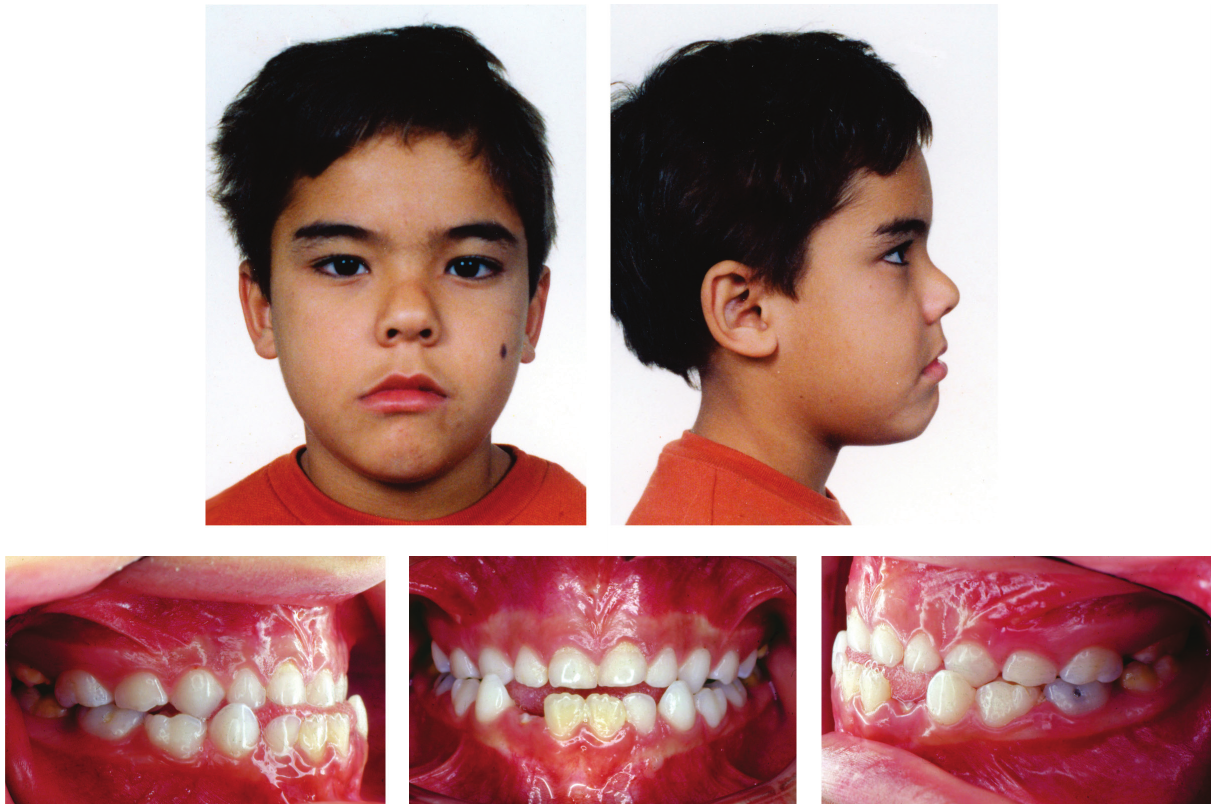
Figure 1- Extra-oral and Intraoral pretreatment photographs. Parents authorized the publication of these